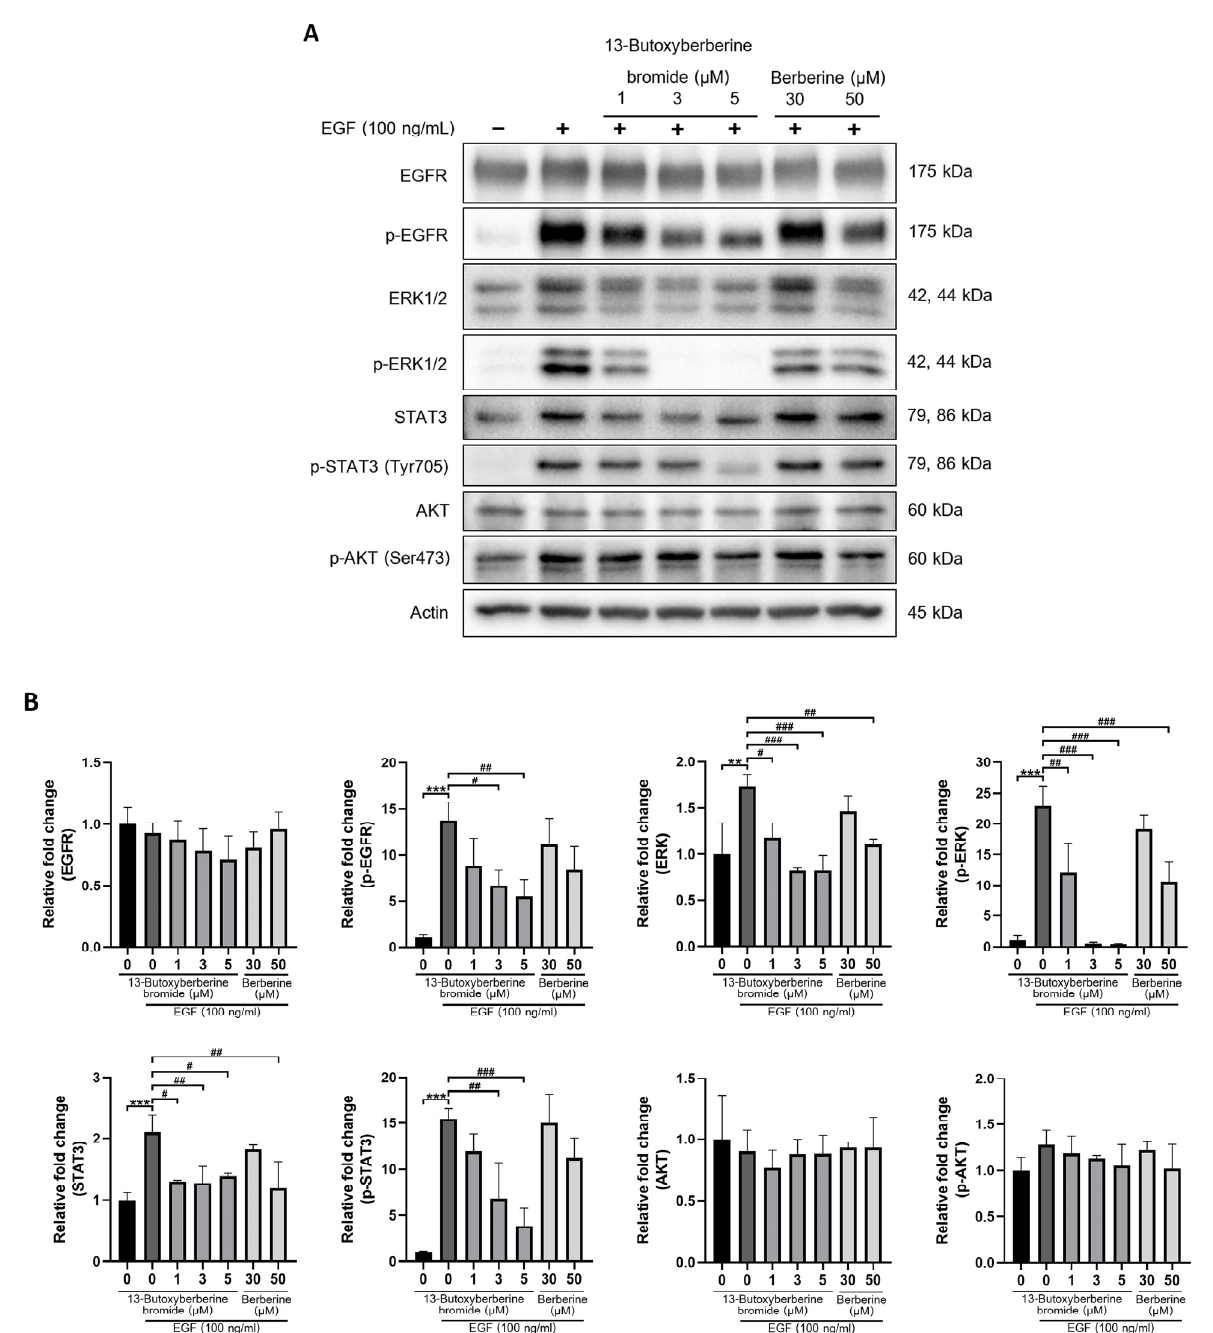
Figure 7. Effect of 13-butoxyberberine bromide on EGFR-mediated ERK, PI3K/Akt, and STAT signaling pathways. Cells were pretreated with 13-butoxyberberine bromide and berberine for 30 min, then induced with EGF for 10 min. ( A ) Protein expressions of EGFR, p-EGFR, ERK, p-ERK, Akt, p-Akt, STAT3, and p-STAT3 were examined using Western blot analysis. ( B ) Relative band intensity was measured using Image J software compared to the control group (0.5% DMSO). Data were expressed as mean ± SD ( n = 3). Actin was used as the loading control. ** p < 0.01 and *** p < 0.001; significant difference from the control group without EGF stimulation. # p < 0.05, ## p < 0.01, and ### p < 0.001; significant difference from the control group with EGF stimulation. 2.8. 13-Butoxyberberine Bromide Inhibited EGF-Induced A431 Cell Migration To confirm that 13-butoxyberberine bromide could inhibit EGF-induced A431 cell migration, cells were examined using a wound-healing assay. After scratching, A431 cells